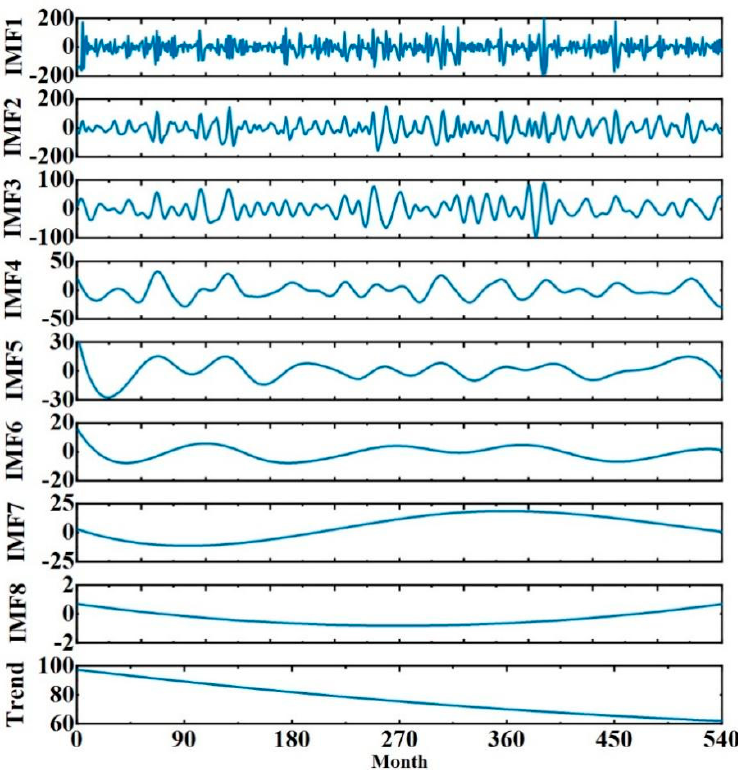
Figure 5. Month-by-month precipitation data for Zhoukou City, 1978–2022.